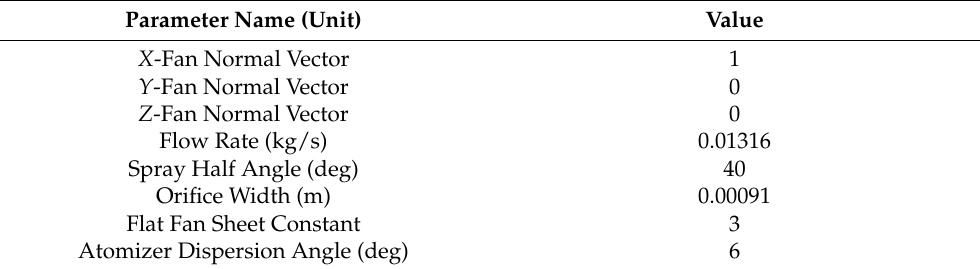
Table 1. Work parameters of flat sector